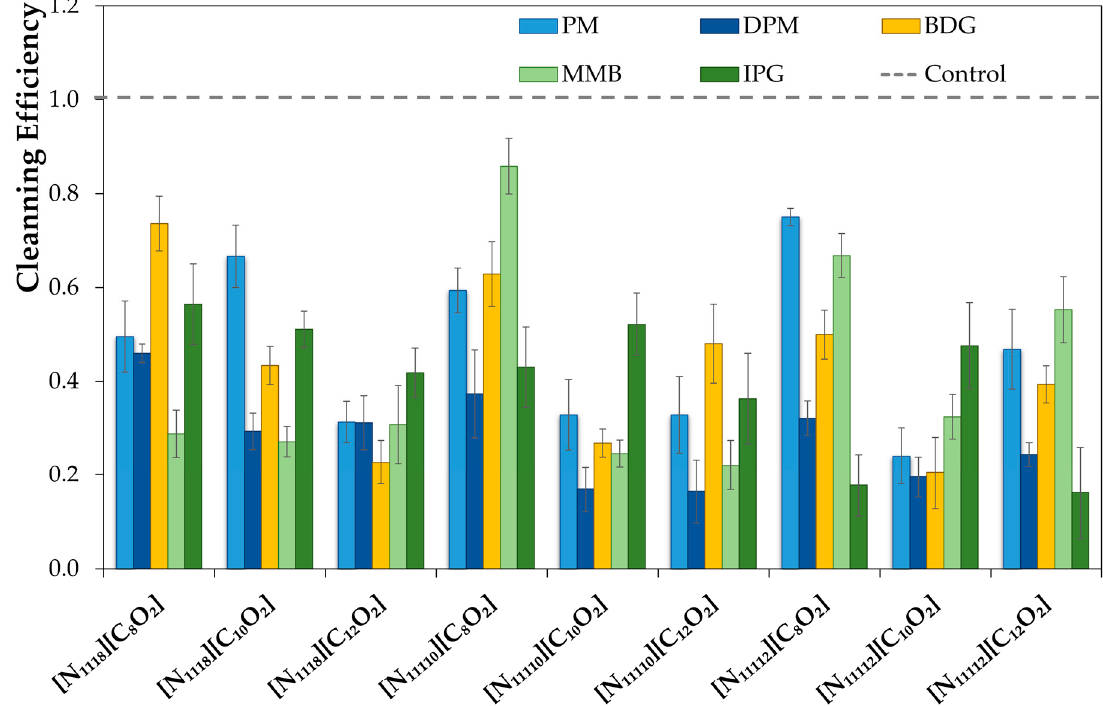
Figure 7. Cleaning efficiency of formulations with ionic surfactants on stainless steel surface obtained by abrasion scrub test: bars represent the cleaning efficiency of the formulation with different solvents, and error bars are the standard deviation of at least five independent